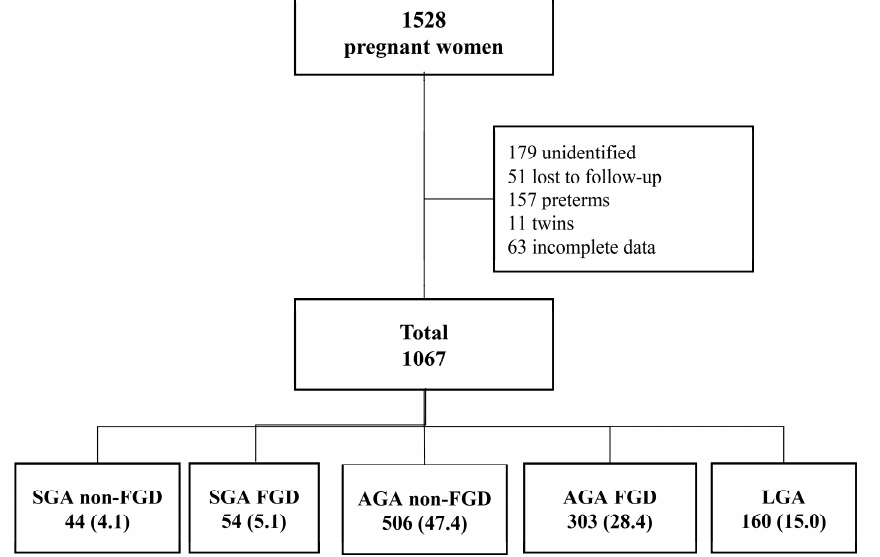
Figure 1. Flowchart of the study cohort. Data are reported as n (%). AGA FGD: appropriate for gestational age with fetal growth detention; AGA non-FGD: appropriate for gestational age without fetal growth detention; LGA: large for gestational age; SGA FGD: small for gestational age with fetal growth detention; SGA non-FGD: small for gestational age without fetal growth detention. Table 1. Descriptive baseline characteristics. Data are reported as n (%) or median and interquartile range (p25th–p75th). AGA FGD: appropriate for gestational age with fetal growth detention; AGA non-FGD: appropriate for gestational age without fetal growth detention; LGA: large for gestational age; NRFS: non-reassuring fetal status; SGA FGD: small